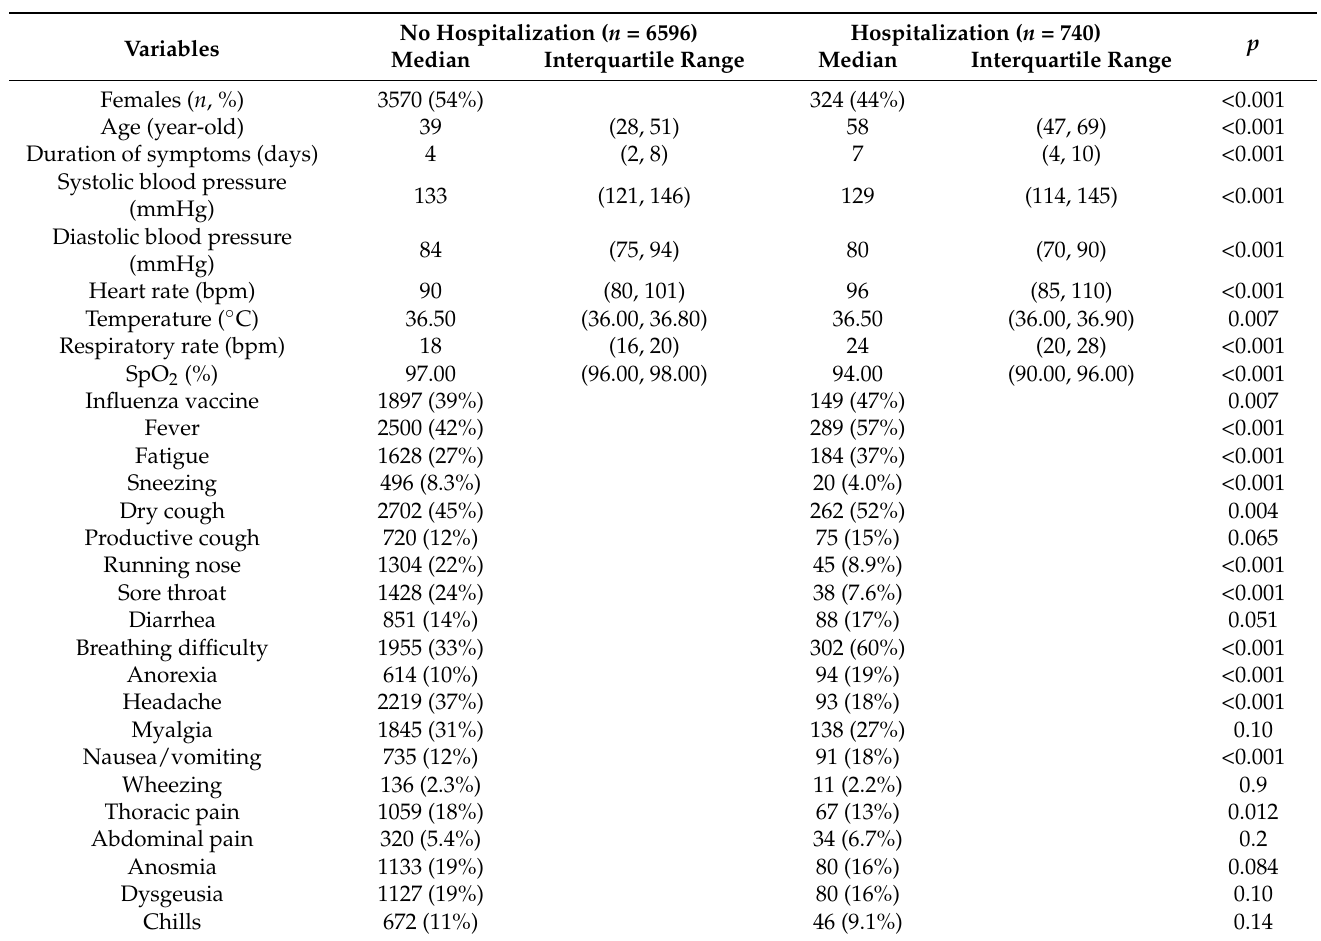
Table 1. Comparison of demography, signs, and symptoms between patients who required hospi- talization and those who did not require hospitalization from March to August 2020 at S ã o Paulo Hospital,